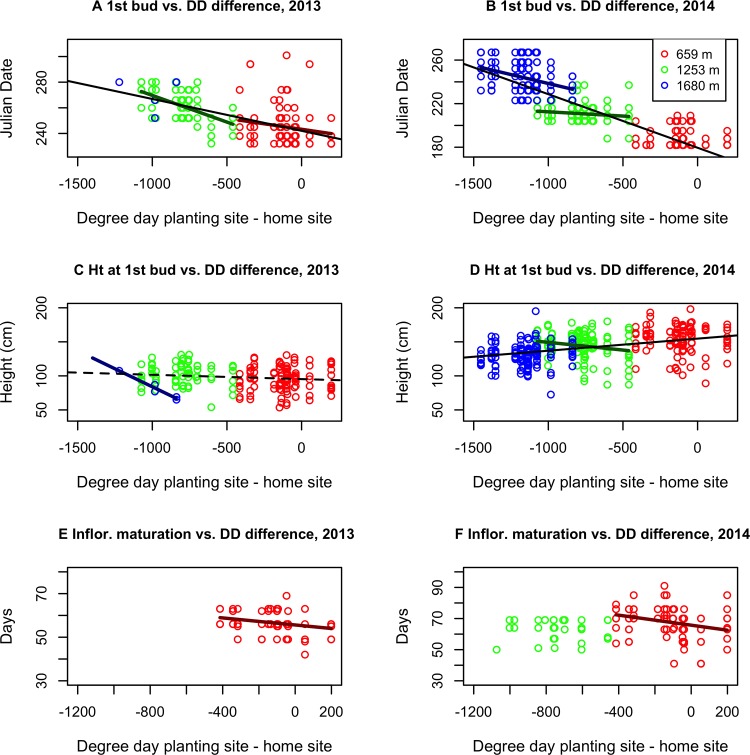
Additional performance measures relative to difference in degree days between planting site and home site.(A) Julian date at which first inflorescence bud recorded, 2013. (B) Julian date of first inflorescence bud, 2014. (C) Plant height at date of first inflorescence bud, 2013. Stems stop growing once apical meristem transforms. (D) Plant height at date of first flower bud, 2014. (E) Time between first bud formation and first inflorescence maturation, 2013. (F) Time between first bud formation and first maturation, 2014. Thick colored lines indicate within-site relationships. Thin black lines indicate across-site relationships. Solid lines indicate statistically significant relationships. Dashed lines indicate marginally significant relationship (p<0.1).